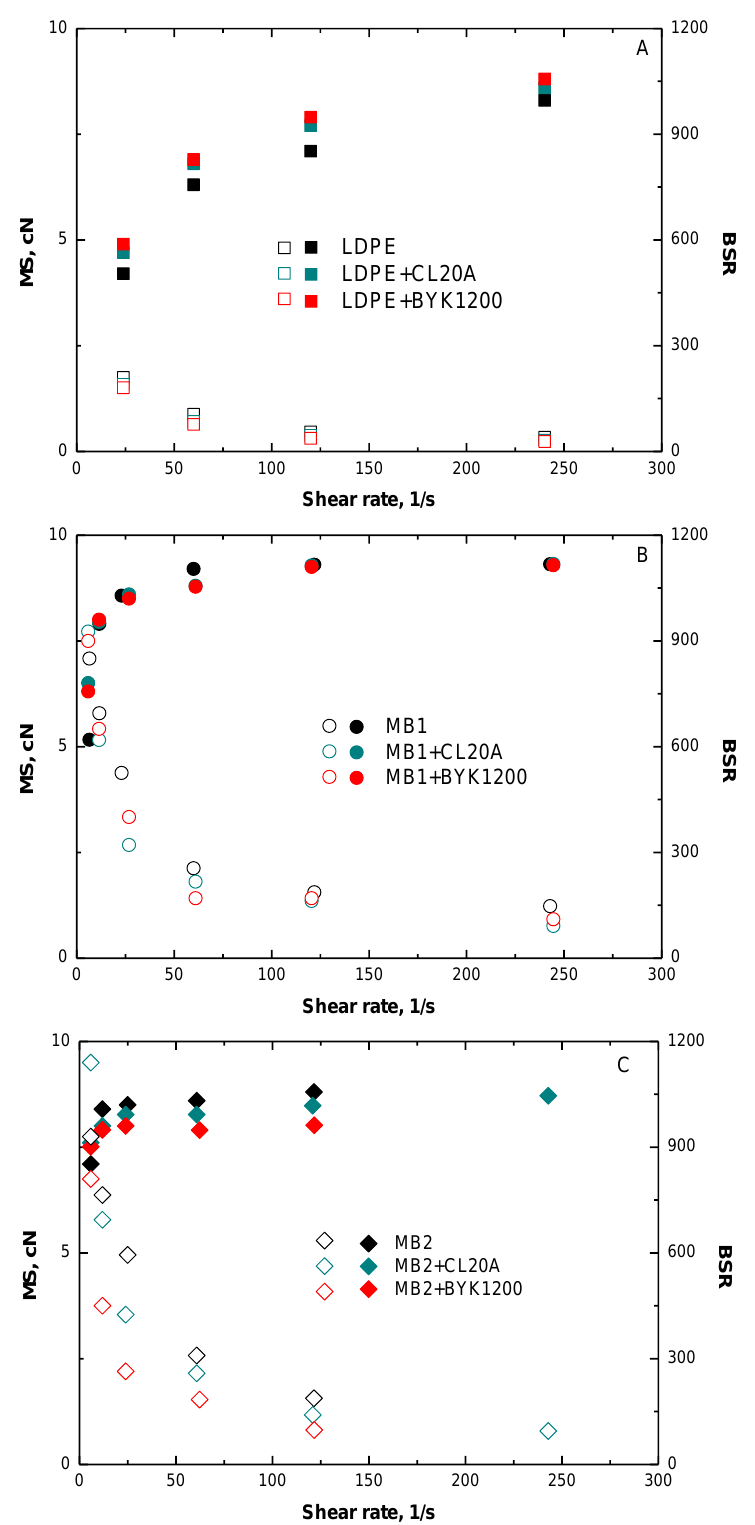
Figure 4. MS (filled symbols) and BSR (blank symbols) values as a function of shear rate for ( A ) LDPE-, ( B ) MB1-, and ( C ) MB2-based nanocomposites. The values for the unfilled matrices are also reported.